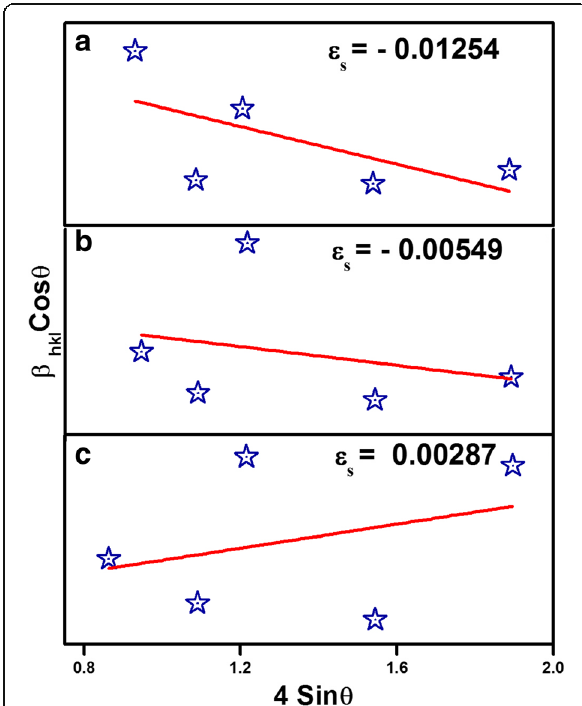
Fig. 2 a W-H plot of Co x Mn y Zn y Fe 2 O 4 with (C1) x = 0.1 and y = 0.45. b W-H plot of Co x Mn y Zn y Fe 2 O 4 with (C5) x = 0.5 and y = 0.25. c . W-H plot of Co x Mn y Zn y Fe 2 O 4 with (C9) x = 0.9 and y = 0.05